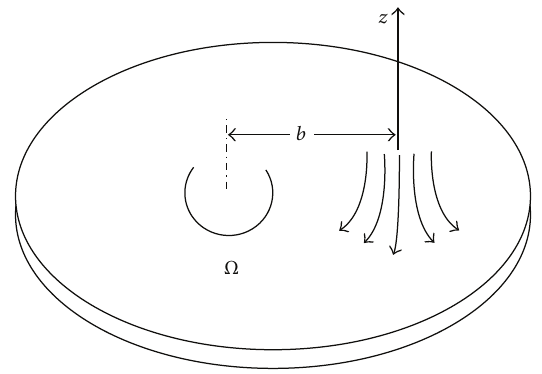
Figure 1: Off-centered stagnation flow on a rotating